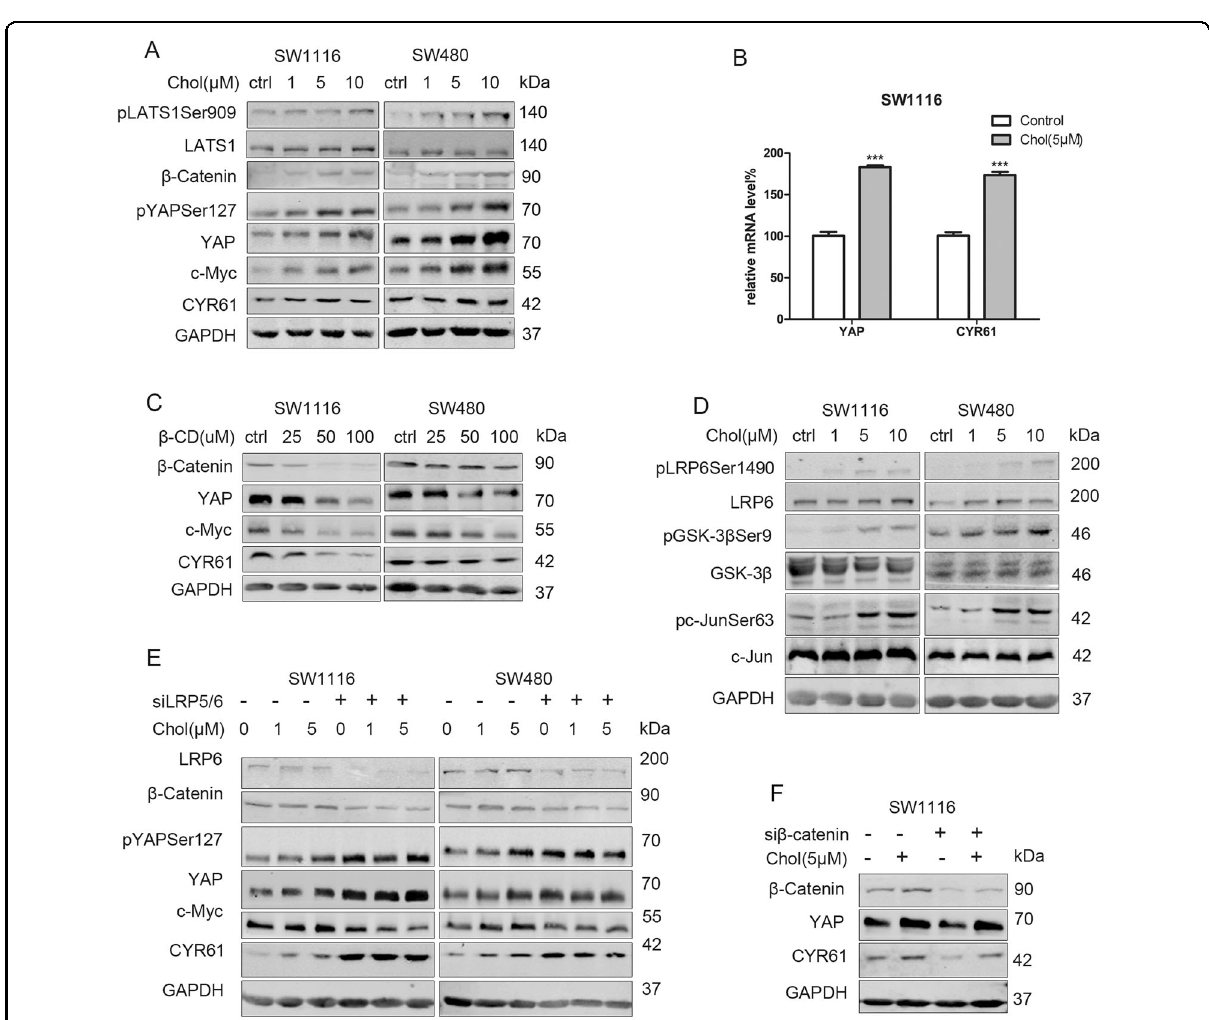
Fig. 3 Cholesterol promotes YAP expression independent of LATS and β -Catenin in colon cancer cells. A SW1116 and SW480 were starved in serum-free medium for 24 h, and then treated with increasing concentration (1 – 10 μ M) of cholesterol for 2 h. B SW1116 were starved for 24 h, and then treated with cholesterol (5 μ M) for 2 h. The mRNA levels of YAP and CYR61 were detected by qPCR. *** p < 0.001 using Student ’ s t test (two- tailed). C Increasing concentration of β -cyclodextrin (25 – 100 μ M) was incubated in SW1116 and SW480 cells for 4 h. (D): SW1116 and SW480 cells were starved for 24 h, incubated with increasing concentration of cholesterol (1 – 10 μ M) for 2 h. E SW1116 and SW480 were transfected with negative control siRNA or LRP5/6 siRNA for 48 h, then starved for 24 h, and incubated with DMSO or cholesterol (1 – 5 μ M) for 2 h. F SW1116 were transfected with negative siRNA or β -Catenin siRNA for 48 h, then starved for 24 h, and then incubated with DMSO or cholesterol (5 μ M) for 2 h. Western blot analysis was performed to detect the expression of